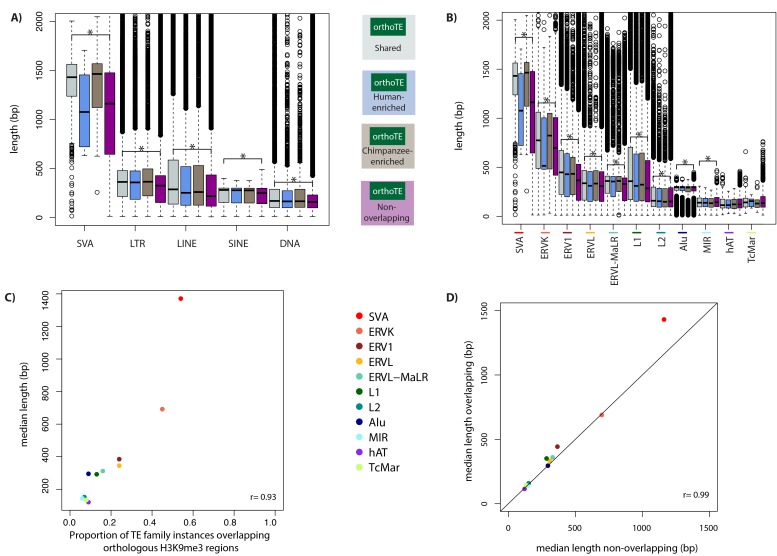
Longer TE families overlap with orthologous H3K9me3 regions more often than shorter families.(A) The length of TEs in each of the TE classes stratified by H3K9me3 enrichment category. (B) The length of TEs in 11 major TE families ordered by the proportion of family members overlapping H3K9me3. (C) The proportion of TE family members that overlap an orthologous H3K9me3 region, and the median TE length in each TE family ordered by the proportion of TEs within a family overlapping H3K9me3 from highest to lowest. Pearson’s correlation coefficient is represented as r. (D) The median length of TEs not overlapping H3K9me3 regions and the median length of TEs that do overlap an H3K9me3 region. Asterisk denotes a significant difference between the Shared and Non-overlapping categories (Wilcoxon-rank sum test; *p<0.001).